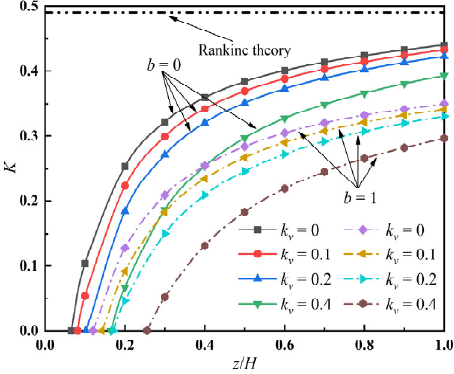
Figure 7. Influence of z and k v on K .